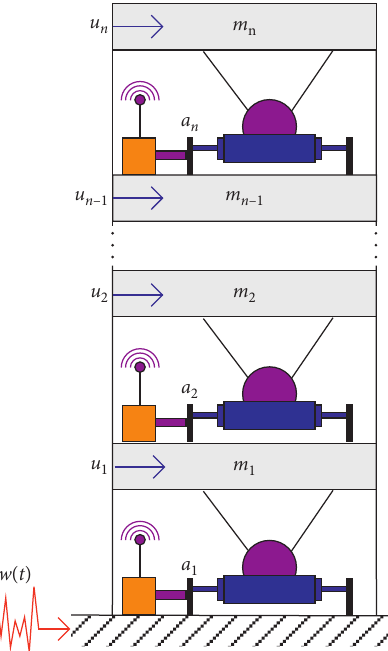
Figure 1: ( n )-story building structural vibration control